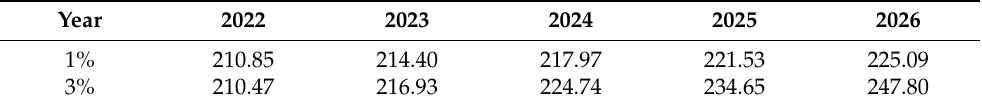
Table 26. Prediction result of water requirement with different growth rates of AVTI in Inner Mongolia.